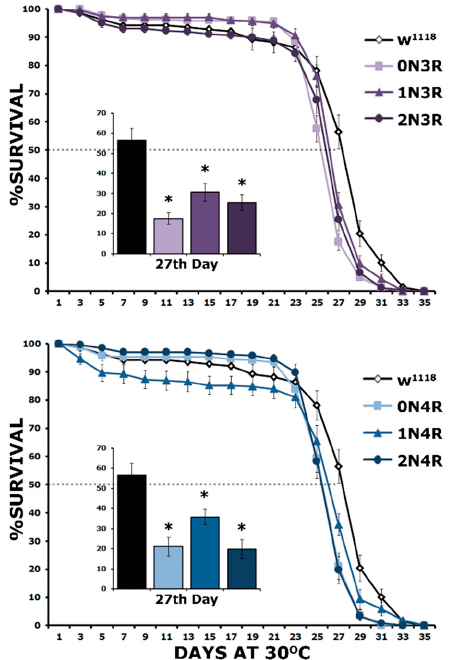
Figure 8. Lifespan is equally decreased by all hTau isoforms. Survival curves for animals accumulating pan-neuronally the six hTau isoforms under elav-GAL4; tub-Gal80ts compared with driver heterozygotes (w 1118 ). Flies were raised at 18 ◦ C, but adults were transferred and maintained at 30 ◦ C until they expired. The data represent the mean ± SEM from two independent experiments with at least 300 flies assessed per genotype. After 27 days, the population of control heterozygotes (w 1118 ) was reduced by 50% (50% attrition) indicated by the dotted line and the number of surviving animals per genotype on that day is quantified in the insert. Stars indicate significant differences from control. Statistical details in Supplemental Table S8.